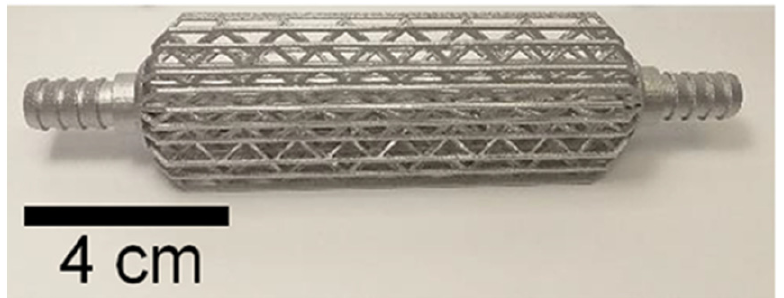
Figure 12. Additively manufactured heat exchangers: a design with a complex fin structure reprinted with permission from Ref. [78]. Copyright 2020 Elsevier.